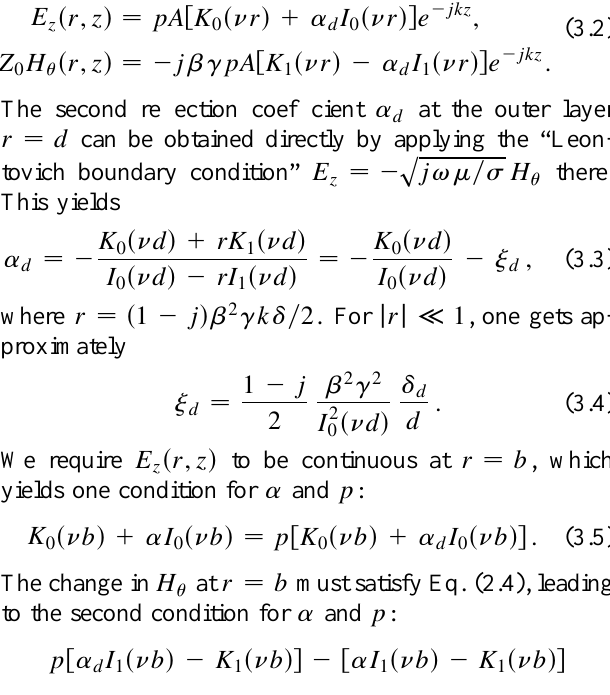
FIG. 2. (Color) Longitudinal impedance calculated with Eq. (3.9) (computed by MATHEMATICA